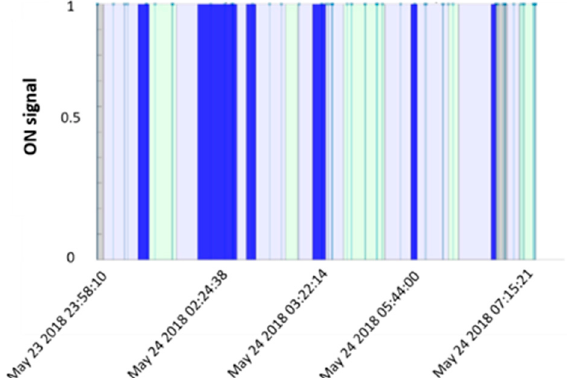
Figure 4. Sleep pattern from PIR and reference sensor output. In grey, AWAKE phases; in dark blue, DEEP phases; in light green, rapid eye movement (REM) phases; in light blue, LIGHT phases (not all the PIR date events are displayed to make the figure readable).